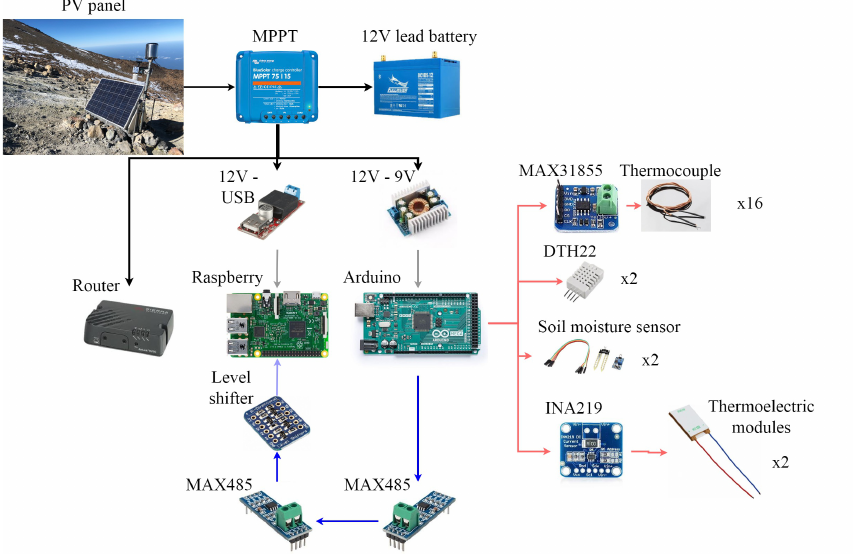
Figure 9. Diagram of the monitoring system including the power supply (black), the RS485 communication (blue), and the sensors